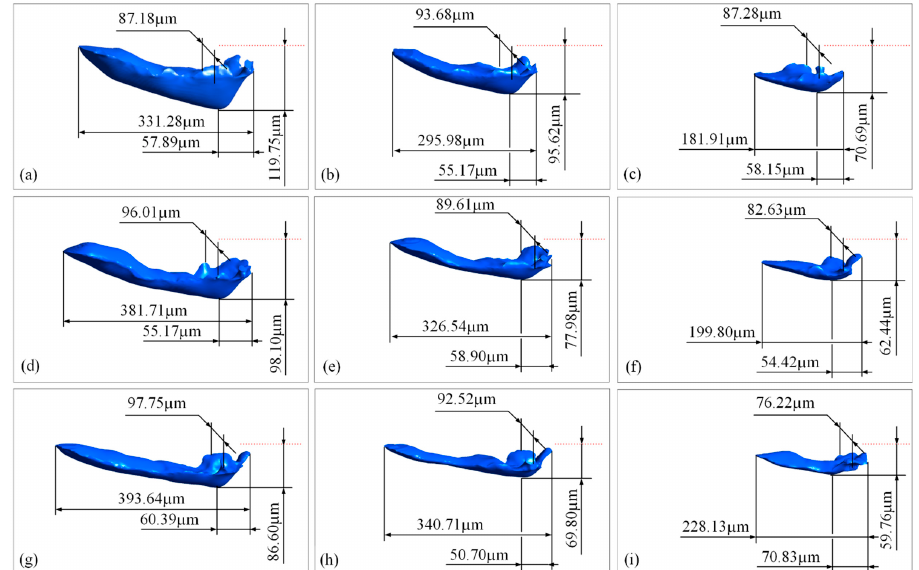
Figure 8. The profile of the molten pool, indicated by the liquidus isothermal surface during laser scanning under different laser powers and scanning speeds. ( a ) 200 W, 1 m/s; ( b ) 150 W, 1 m/s; ( c ) 100 W, 1 m/s; ( d ) 200 W, 1.5 m/s; ( e ) 150 W, 1.5 m/s; ( f ) 100 W, 1.5 m/s; ( g ) 200 W, 2 m/s; ( h ) 150 W, 2 m/s; ( i ) 100 W, 2 m/s. To study the evolution characteristics of the molten pool, the depth, width, length, and front distance of the molten pool under the aforementioned laser parameters were plotted in Figure 9. The results show the following: (1) When the laser power is low or the scanning speed is high, the depth of the molten pool is close to its front distance, about 60 μ m, as the case of 100 W and 2 m/s shown in Figure 9. (2) As the power increases or the scanning speed decreases, the depth of the molten pool gradually approaches and even exceeds its width, reaching about 120 μ m, as the case of 200 W and 1 m/s shown in Figure 9. (3) During the laser-scanning process, the stability of the depth of the molten pool is the highest, followed by the width and the front distance, and the length is the lowest, fluctu- ating in the range of tens of microns.